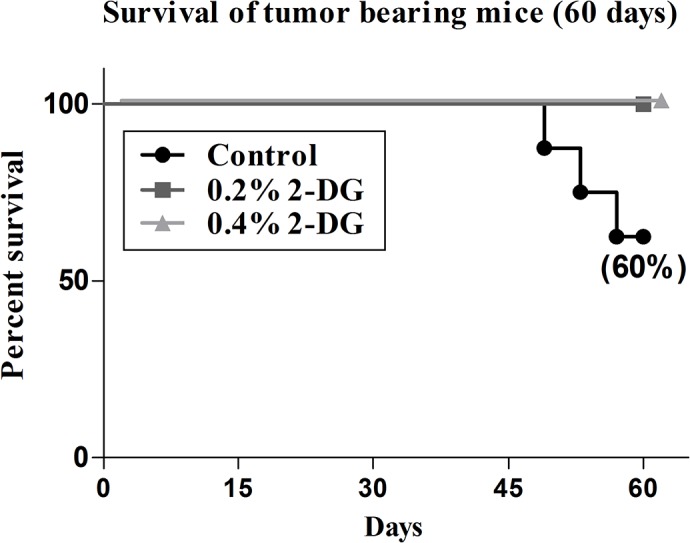
2-DG administration significantly enhanced the survival of EAC tumor bearing mice.Kaplan-Meier plot showing differences in the tumor burden related death observed till day 60 post implant. The Log rank analysis of the survival plot showed a significant increase in the lifespan of tumor bearing mice fed with 2-DG (p < 0.05) at both the doses.